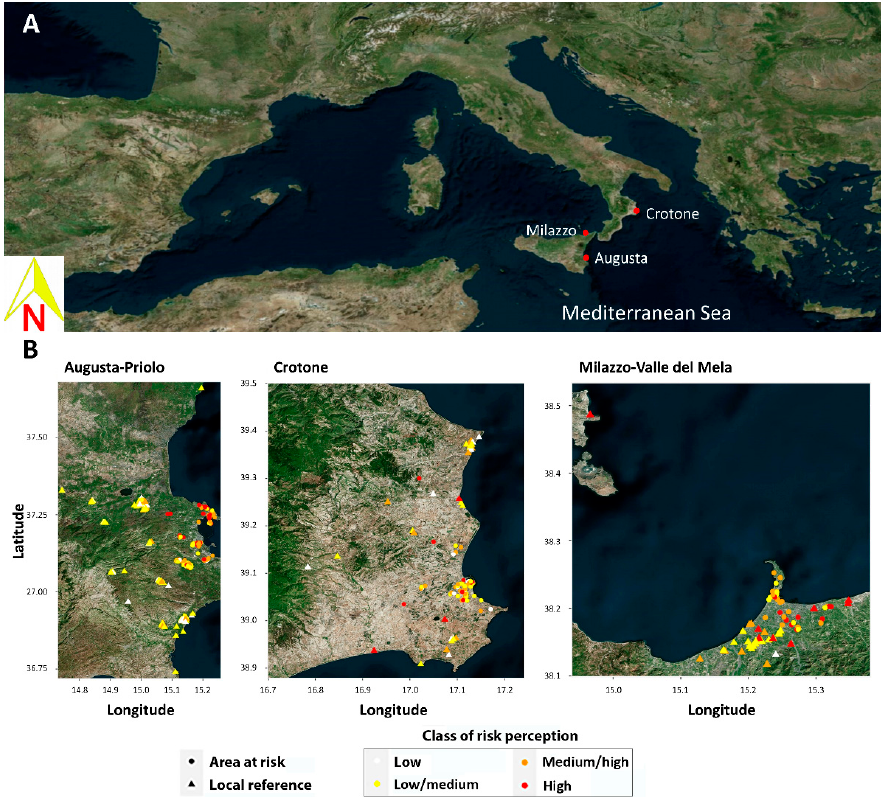
Figure 3. Geographical distribution of mothers in each national priority contaminated site (NPCS). The different colours in panel ( B ) are relevant to the different four classes of risk perception (white: low risk; yellow: low/medium; orange: medium/high; red: high). Circles refer to the residence in NPCSs and triangles in local reference areas.